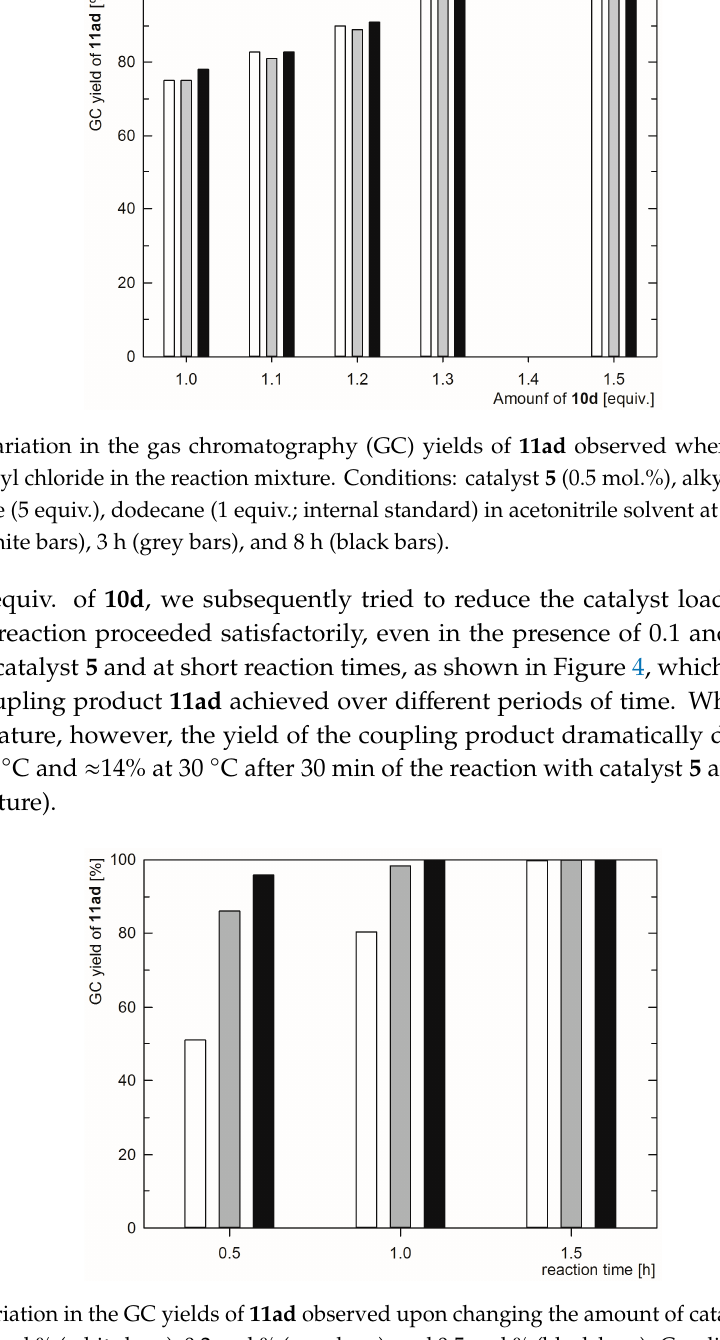
Figure 4. Variation in the GC yields of 11ad observed upon changing the amount of catalyst 5 . Catalyst loading: 0.1 mol.% (white bars), 0.2 mol.% (grey bars), and 0.5 mol.% (black bars). Conditions: alkyne 9a (1 equiv.), acyl chloride 10d (1.5 equiv.), triethylamine (5 equiv.), dodecane (1 equiv.; internal standard) in acetonitrile solvent at 50 °C.